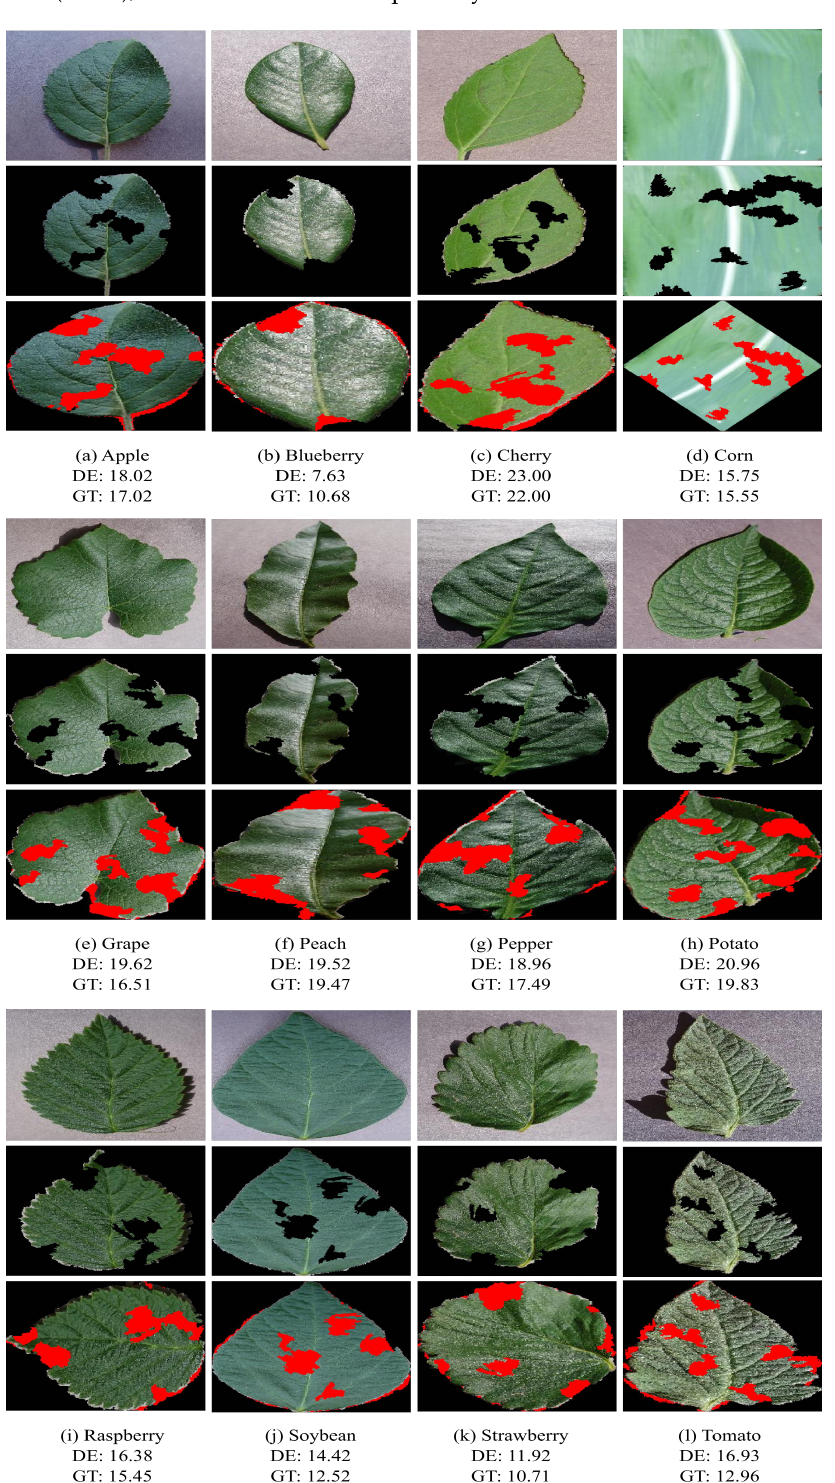
Figure 2. Visual results of our method. The first row of each figure panel shows the images as they are in the data set, the second row presents the query images after segmentation and defoliation, and the third row presents the final result with defoliation estimate (DE) and ground truth